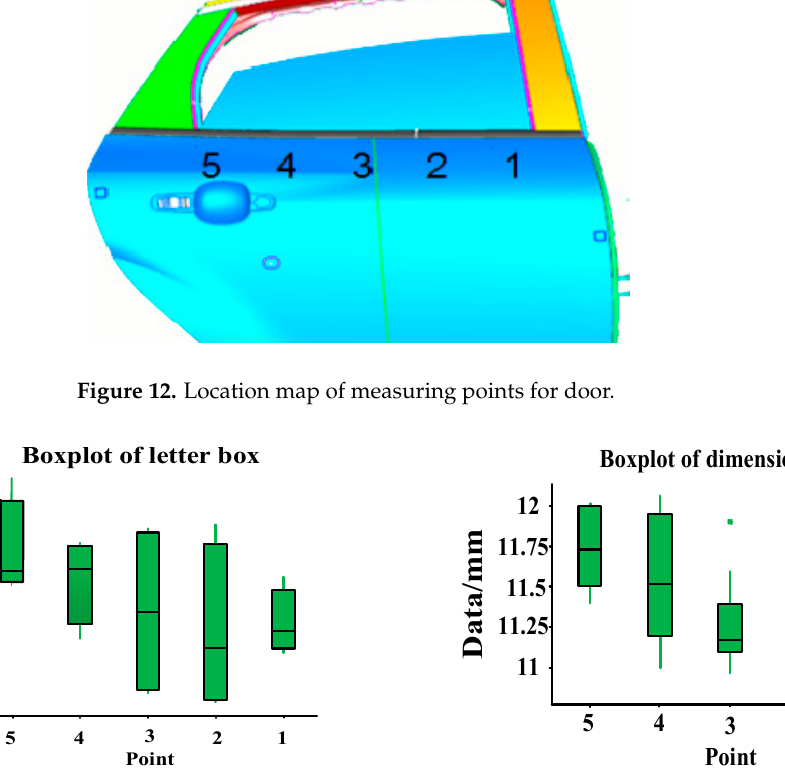
Figure 11. Structure diagram of the window.